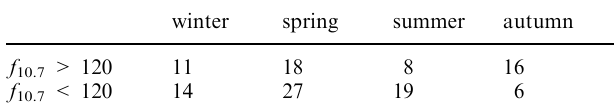
< 11 in solid line p